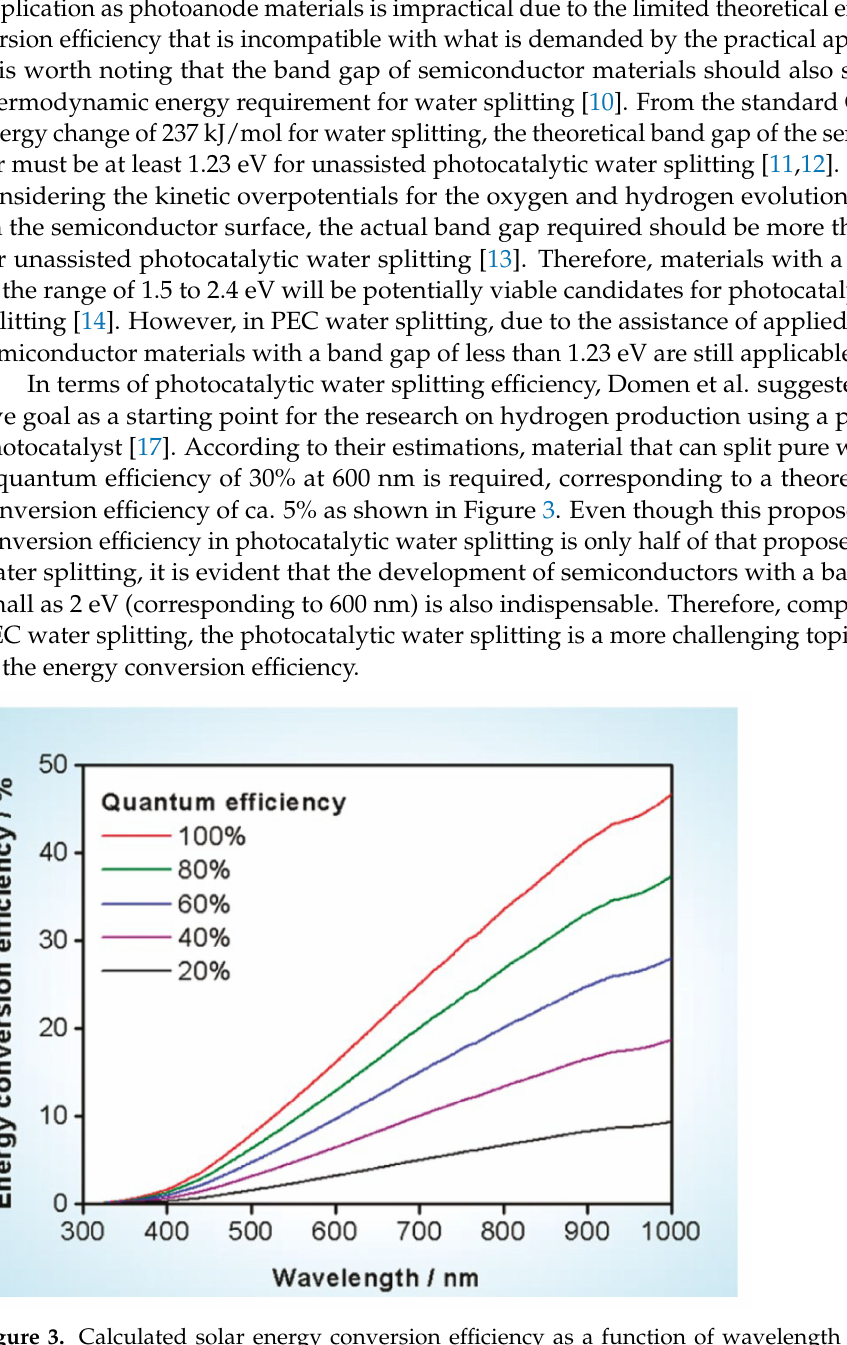
Figure 3. Calculated solar energy conversion efficiency as a function of wavelength for overall water splitting using photocatalysts with various quantum efficiencies. Solar irradiance used for the calculation was taken from AM 1.5G data. Reproduced with permission from [17]. Copyright American Chemical Society,